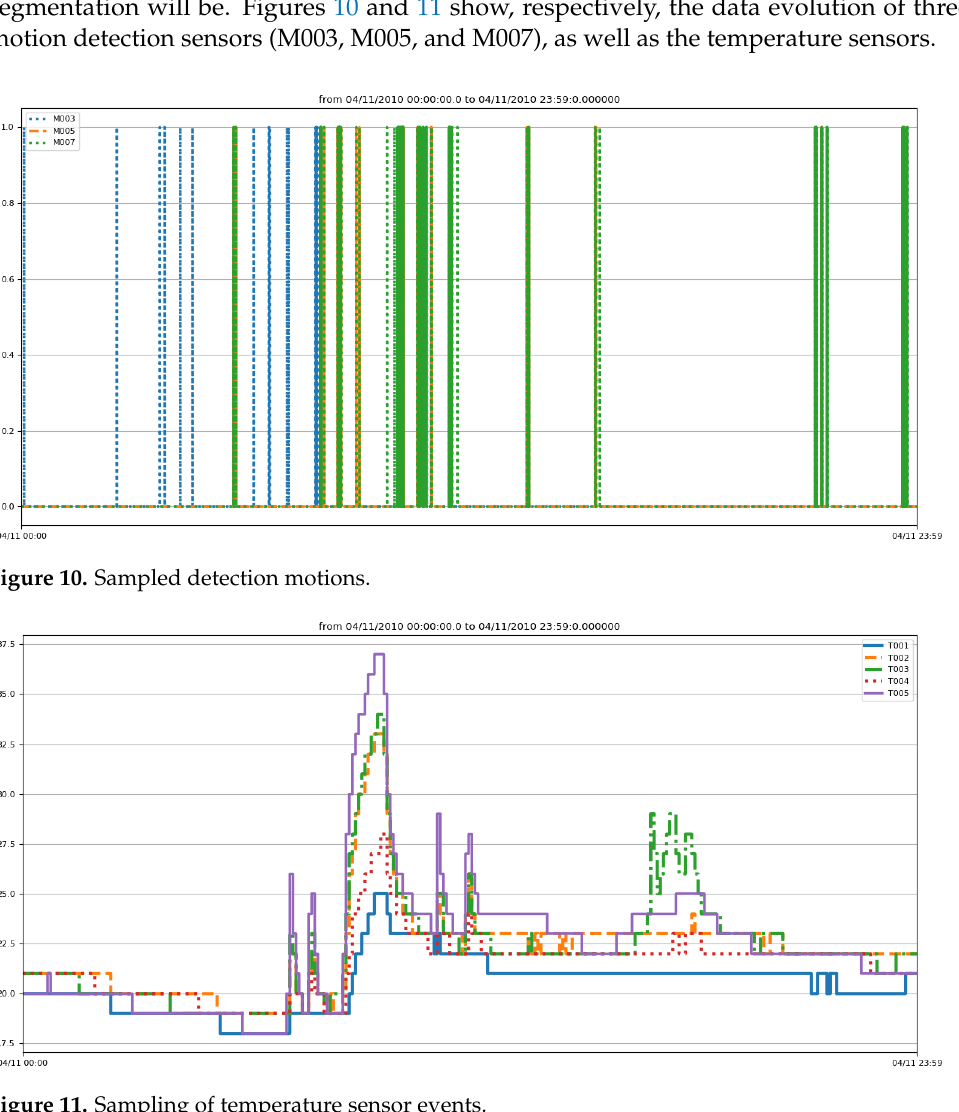
Figure 11. Sampling of temperature sensor